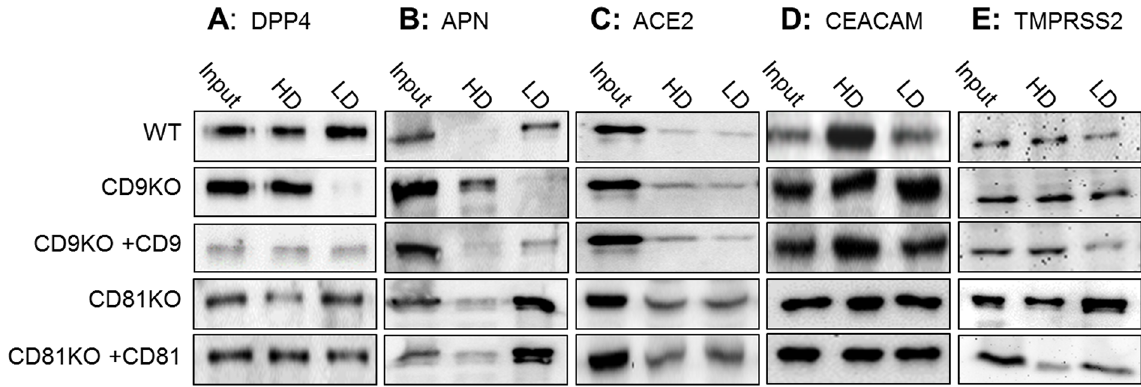
Fig 2. Association of CoV entry factors with CHAPS-resistant membranesin the presenceor absence of CD9 or CD81. 293T WT, CD9KO, or CD81KO cells were transfected with the CoV receptors DPP4 (A), APN (B), ACE2 (C), CEACAM (D), or the proteaseTMPRSS2 (E). KO cells were also complementedwith the appropriate tetraspanin. Cell-surface proteins were biotinylated before cells were lysed in cold CHAPS and clearedlysates were subjectedto ultracentrifugation. Cell surface proteins were isolated by streptavidinpulldownand analyzedin high density (HD) and low density (LD) fractions by western blot.